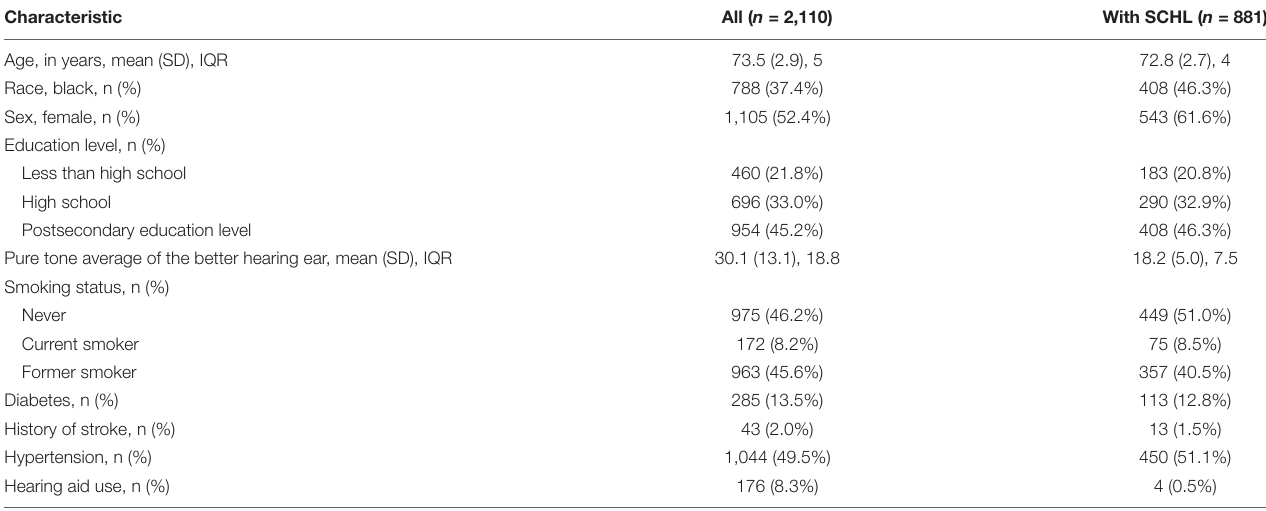
TABLE 1 | Mean (SD) and frequency (%) of demographic variables and comorbidities among all subjects and individuals with SCHL.